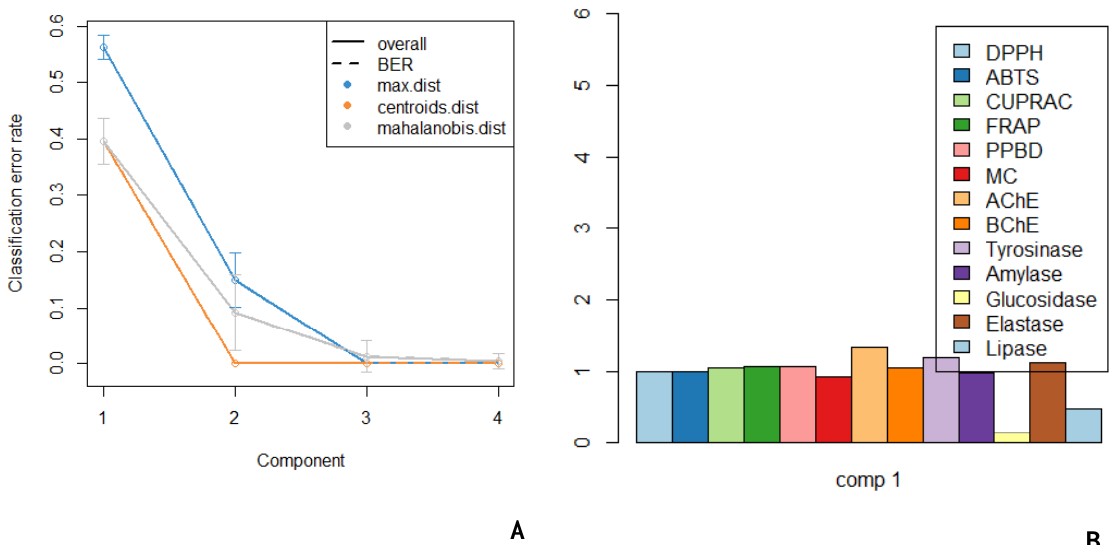
Figure 5. ( A ) Prediction model performance. ( B ) Variable importance in projection (VIP); biological activities with VIP greater than 1 were most relevant for discriminating the extracts.